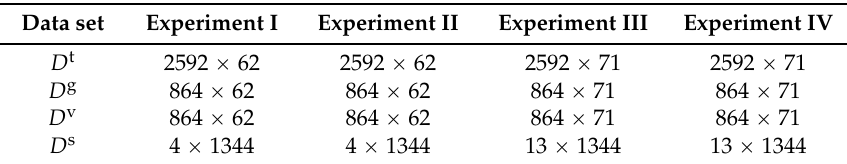
Table 8. Size of training, testing and validation sets.